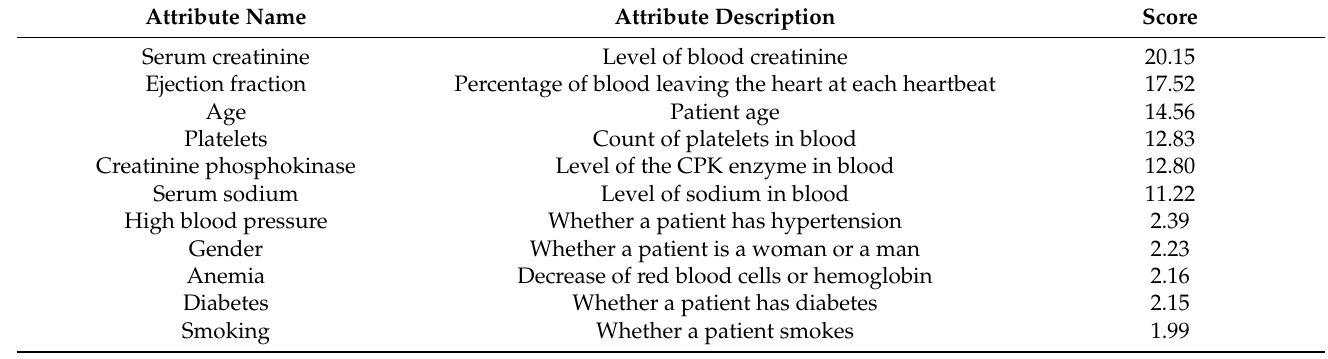
Table 4. Selected attributes from the Faisalabad dataset with Random Forest.